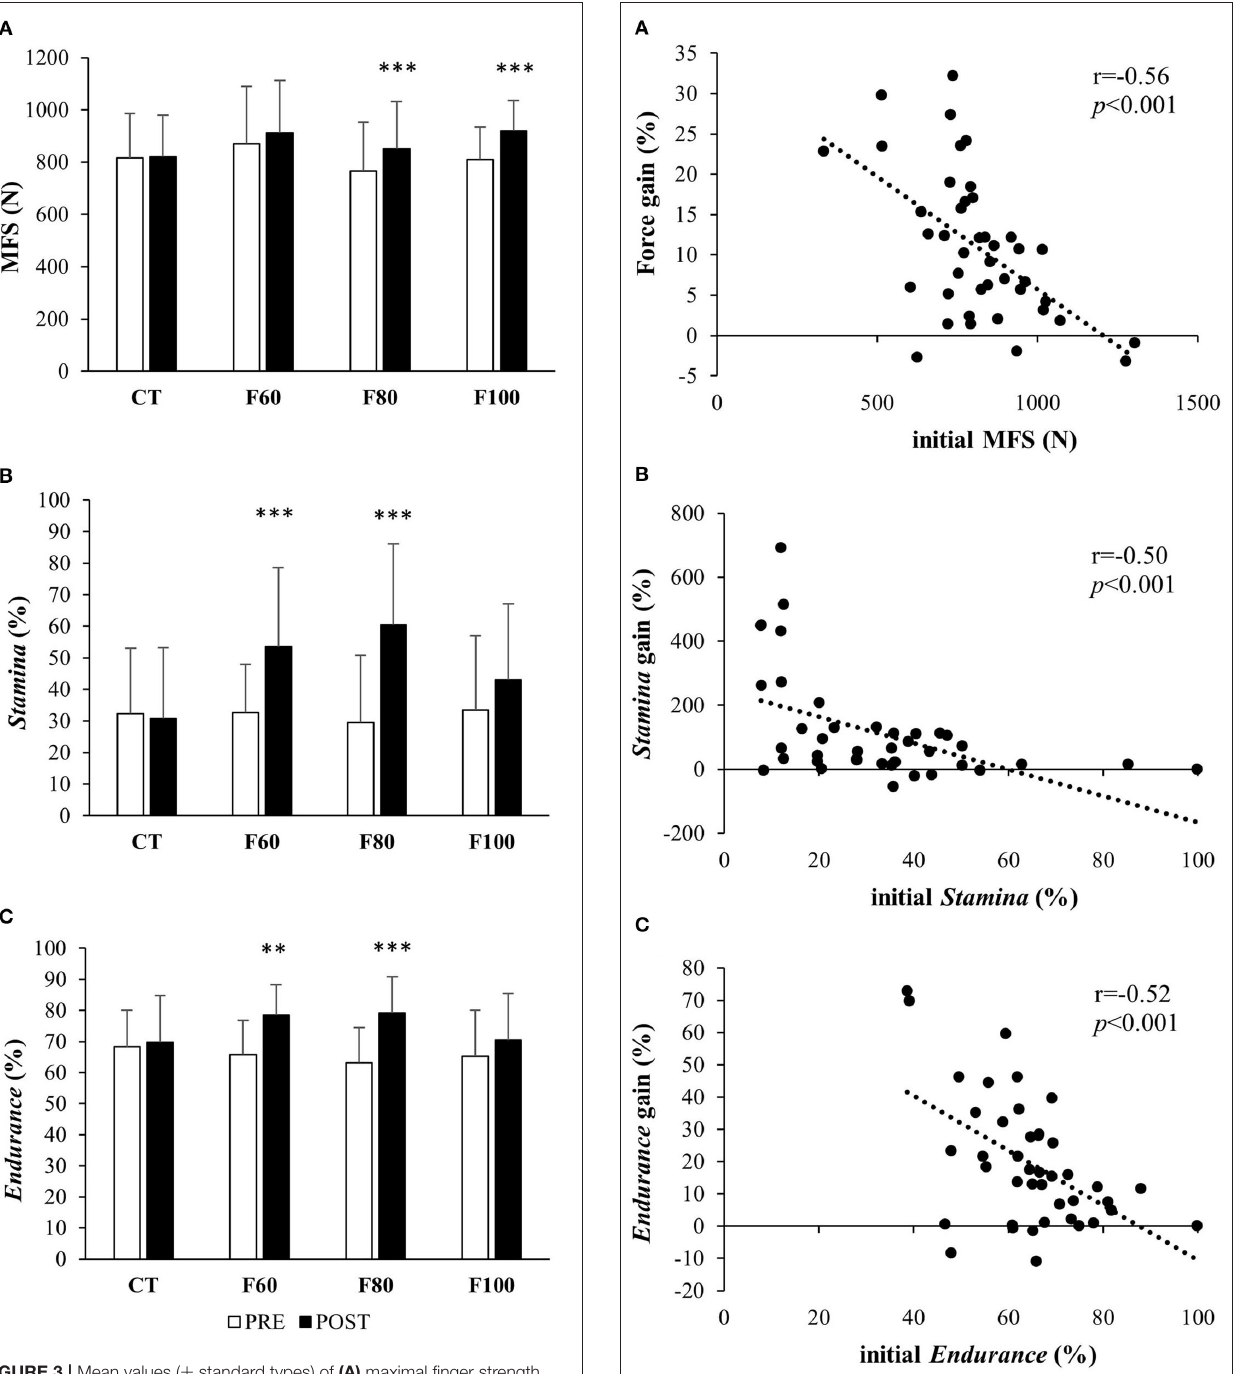
( + 0.7 ± 5.0%; + 5.9 ± 8.2%; + 12.4 ± 8.4% and + 14.3 ± 8.8% for the CT, F60, F80, and F100 groups, respectively). Post-hoc tests